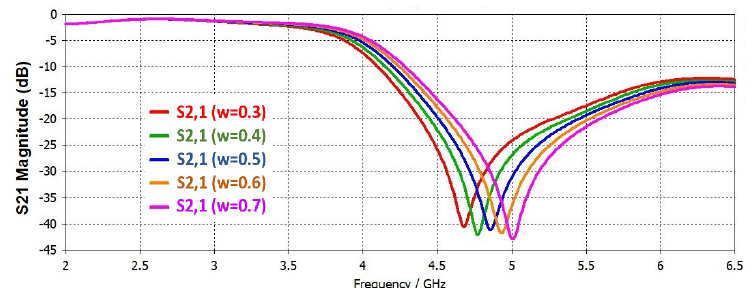
Figure 4. Simulated S 21 in case of variation in resonator length (L).